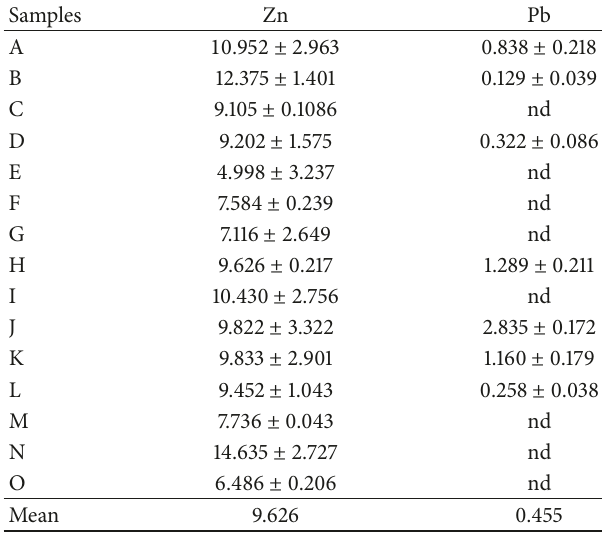
Table 2: Mean contents ( 𝜇 g 50 mL −1 ) of heavy metals present in a cup (50mL) of coffee